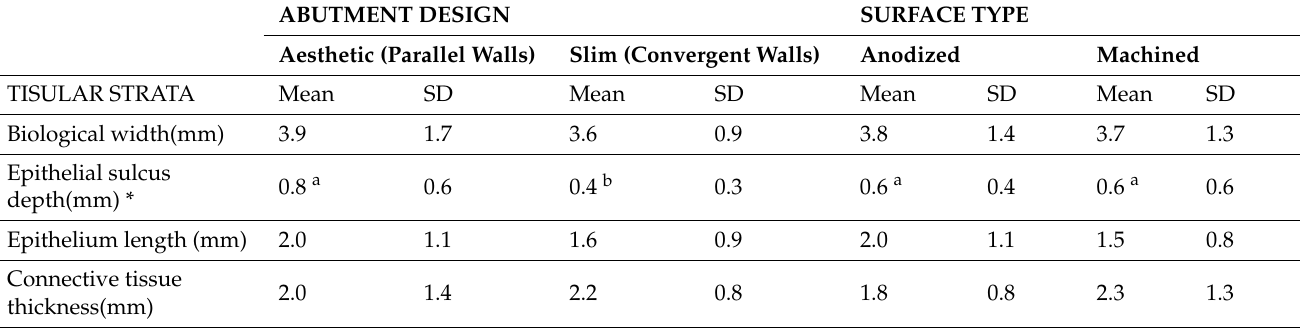
Table 2. Comparison by ANOVA of the effect of both abutment design (parallel vs. convergent) and the surface type (anodized vs. machined) on the gingival tissue strata.